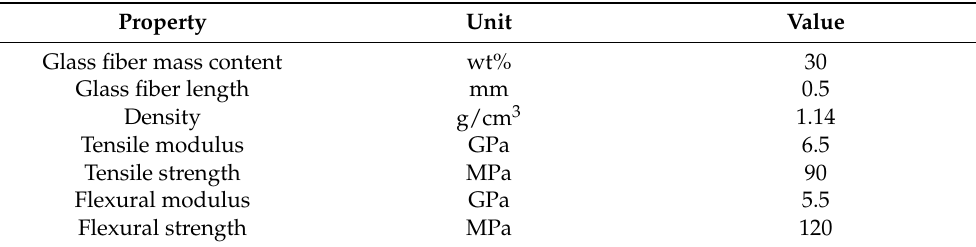
Table 2. Properties of the PP/GF30 short fiber-reinforced thermoplastic composite used for over- molding of TPCs as provided by the